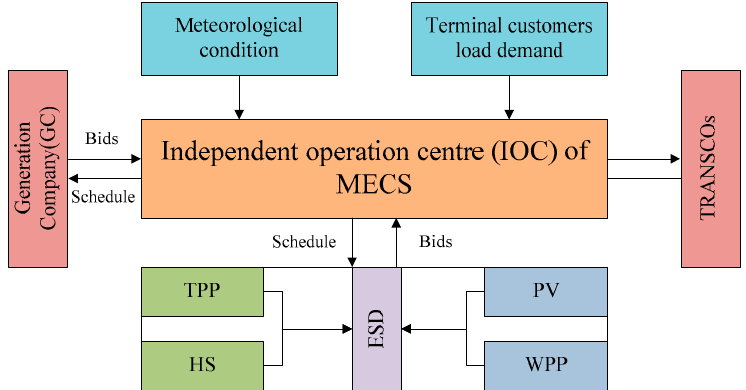
Figure 1. The basic structure of the multi-energy complementary system (MECS) operation.